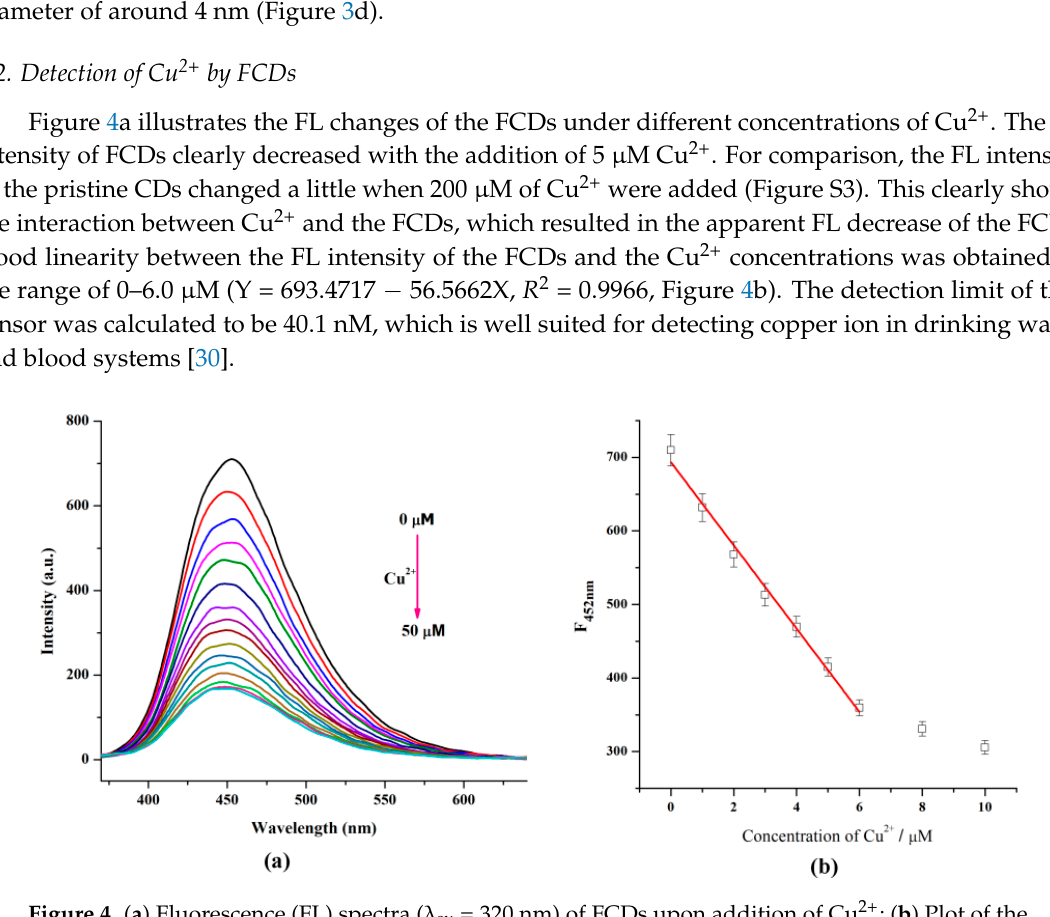
Figure 4. ( a ) Fluorescence (FL) spectra ( λ ex = 320 nm) of FCDs upon addition of Cu 2+ ; ( b ) Plot of the FL intensity of FCDs against Cu 2+ concentration, λ ex = 320 nm, λ em = 452 nm.